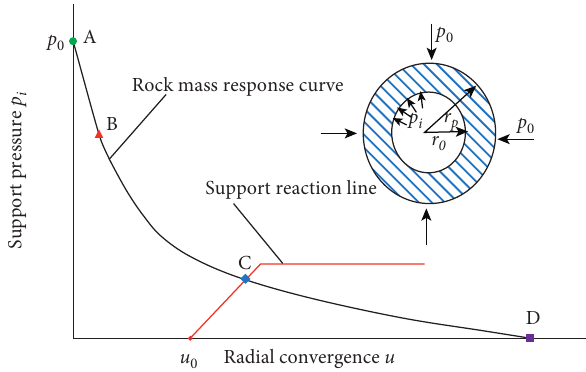
Figure 1: Rock-support interaction curve for a